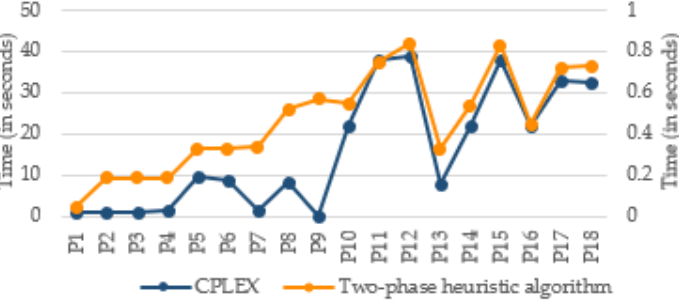
Figure 5. Computation times for CPLEX and proposed heuristics for 18 problem instances.